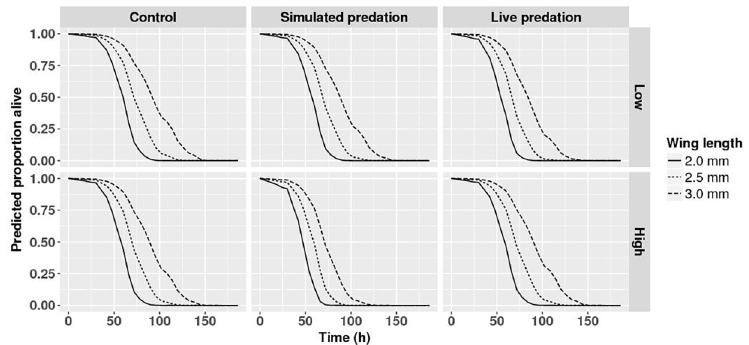
Fig 3. Survival analysis for female mosquitoes. Survival analysis describing predicted survivorship of Aedes aegypti for intraspecific competition × predation treatments across replicate containers for female mosquitoes exposed to ‘medium’ nutrition treatment. Panels along the Y and X axes represent intraspecific competition and predation treatments respectively. Data were statistically tested using Cox proportional hazard regression and significant effects are described in Table